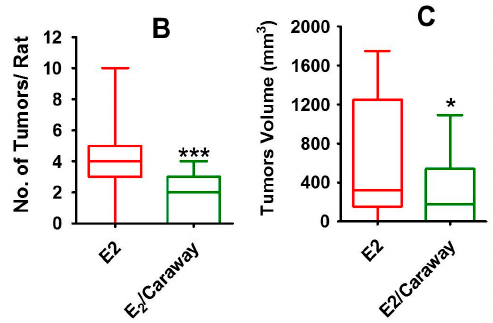
Figure 6. The effect of caraway supplemented diet (7.5%) on tumor indices. After challenging with E2 implants, female ACI rats were palpated starting 12 weeks. Incidence ( A ) were analyzed by nonparametric log-rank test. Tumor multiplicity ( B ) and tumor volume ( C ) were calculated at the time of euthanasia. Statistical analysis was done by two-tailed student’s t -test. * p < 0.05; *** p < 0.001.